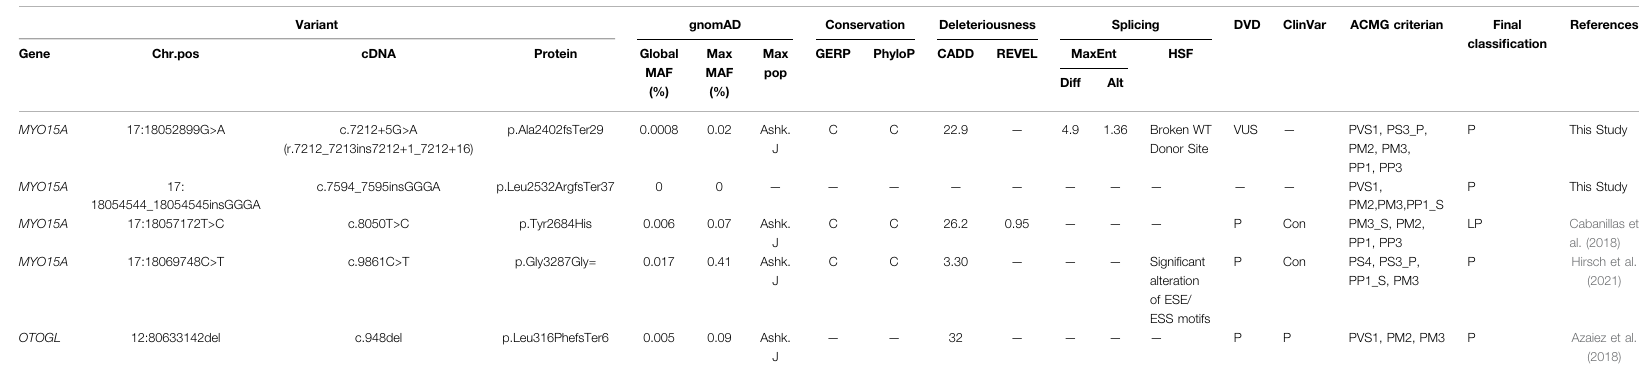
TABLE 1 | Variant